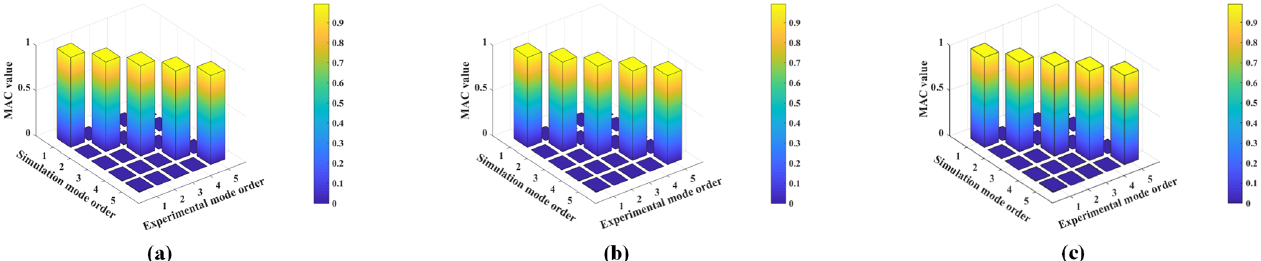
Figure 13. Modal assurance criterion